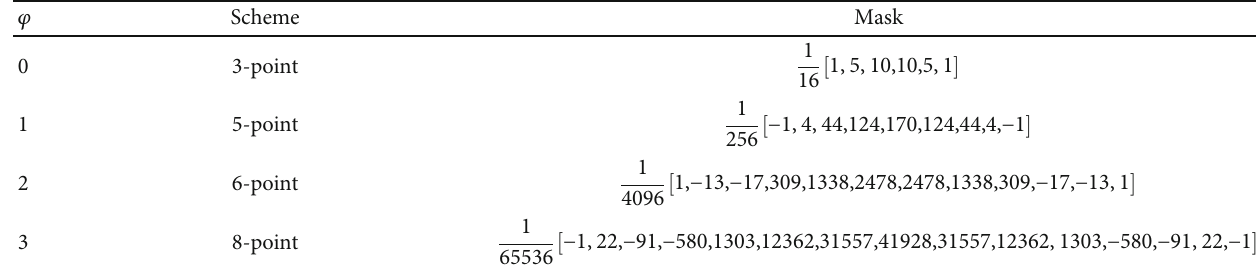
Table 1: Mask of the R φ schemes corresponding to di